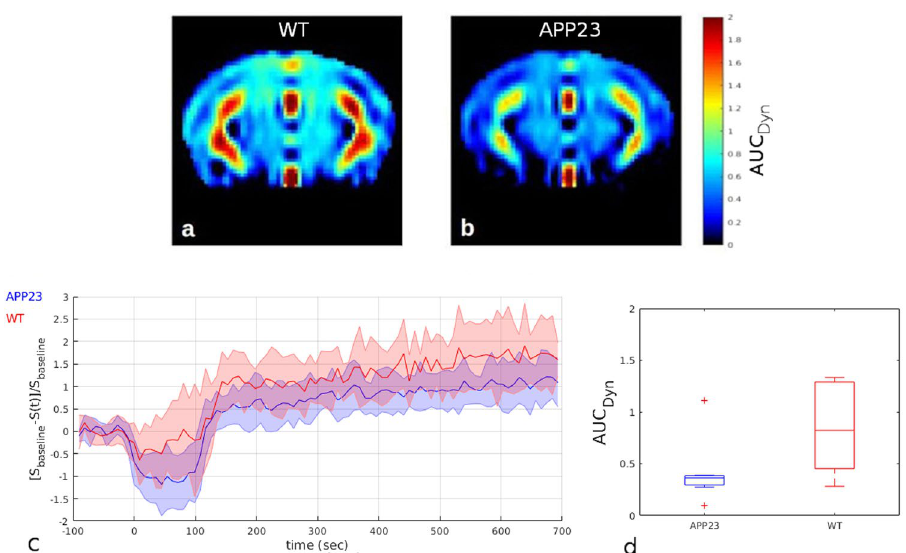
Figure 5. DynamicCEST measurements. ( a , b ) Group mean AUC Dyn images normalized to the template. ( c ) group mean dynamic curves obtained by averaging the signal in the cortex. ( d ) AUC Dyn calculated in the cortex